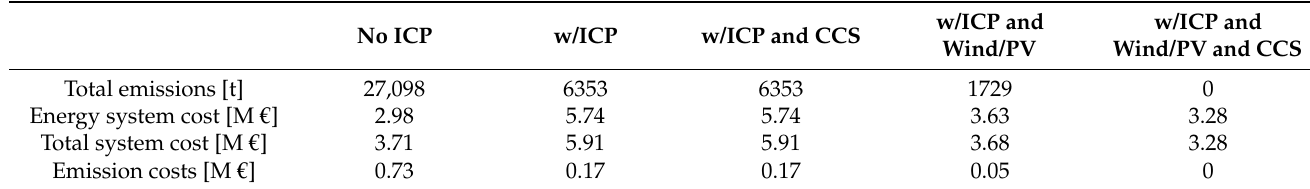
Figure 8. Energy generation for the British scenarios in 2040. Table 9. Cost and emission overview for the British scenarios.